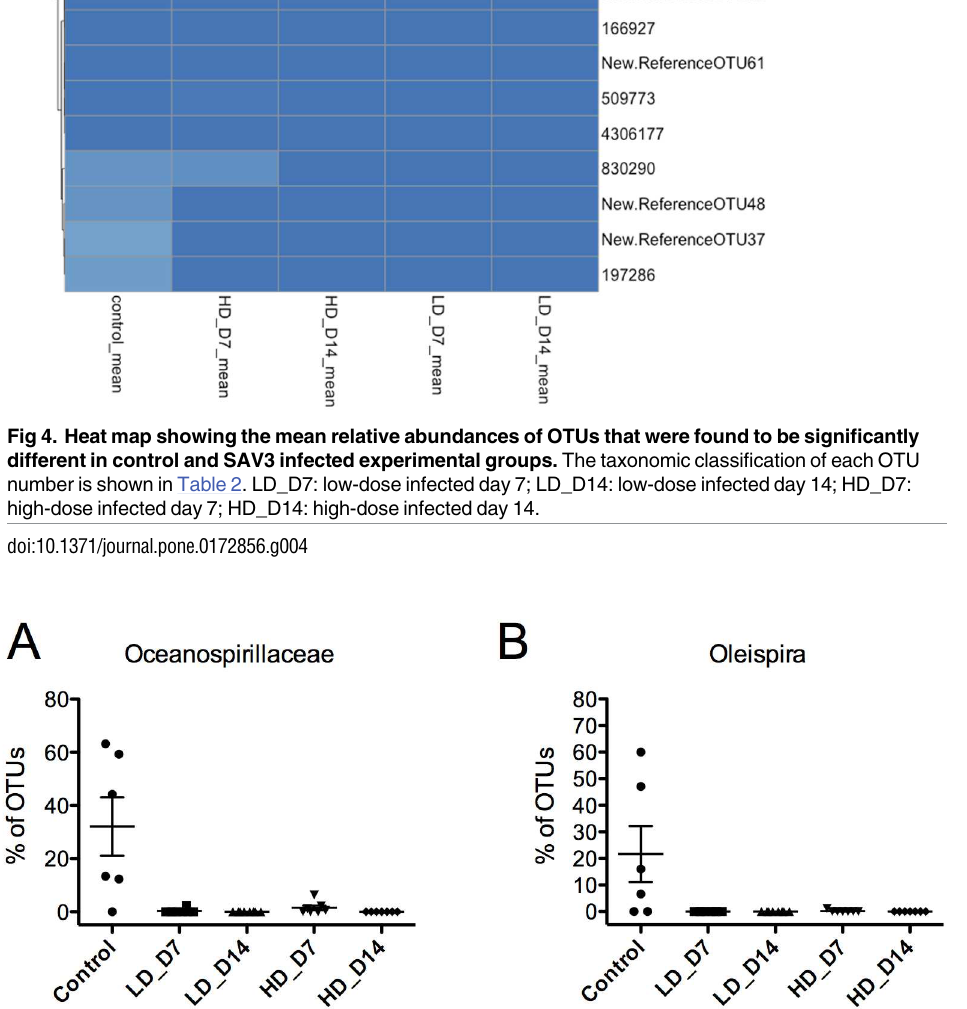
Fig 5. SAV3 infection results in losses of beneficial bacteria in Atlantic salmon skin. Percentage of total OTUs respresented by Oceanospirillaceae (A) and Oleispirasp . (B) in control and SAV-infected groups. The P values obtainedin the statistical analysisare shown in Table 2. LD_D7: low-doseinfected day 7; LD_D14:low- dose infected day 14; HD_D7: high-doseinfected day 7; HD_D14:high-doseinfected day